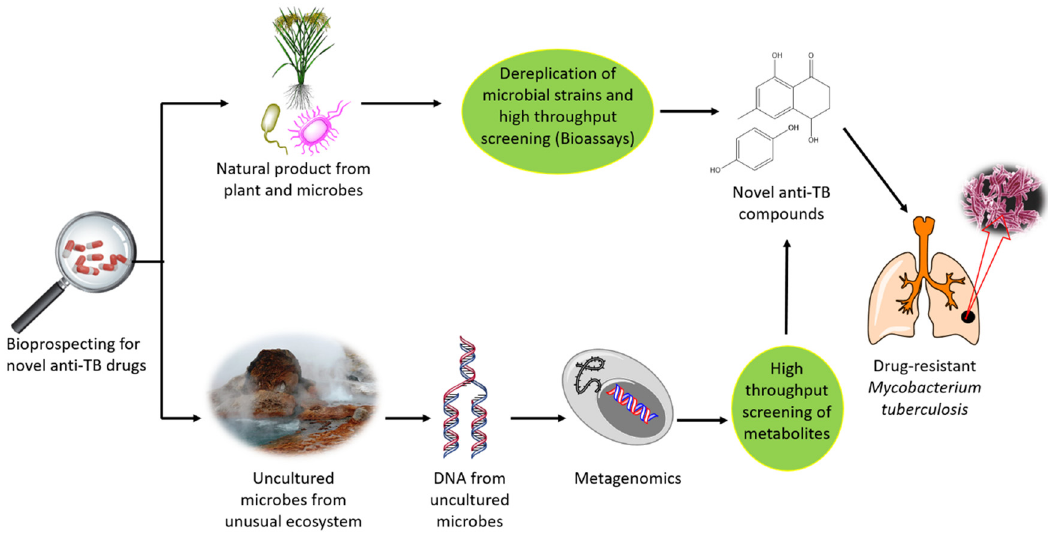
Figure 3: Bioprospecting strategies for antituberculosis drug